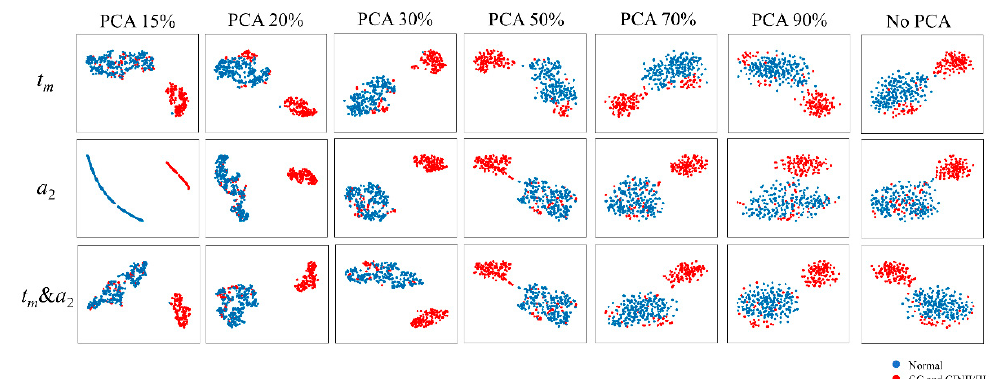
Figure 4. t-SNE projection of feature data extracted from three input images of the training dataset and the preserved different total variances of the data. Each point represents one FLIM image data. Blue points are from 217 FLIM images of the normal group and red points are from 151 FLIM images of cervical cancer or CINII/III groups.